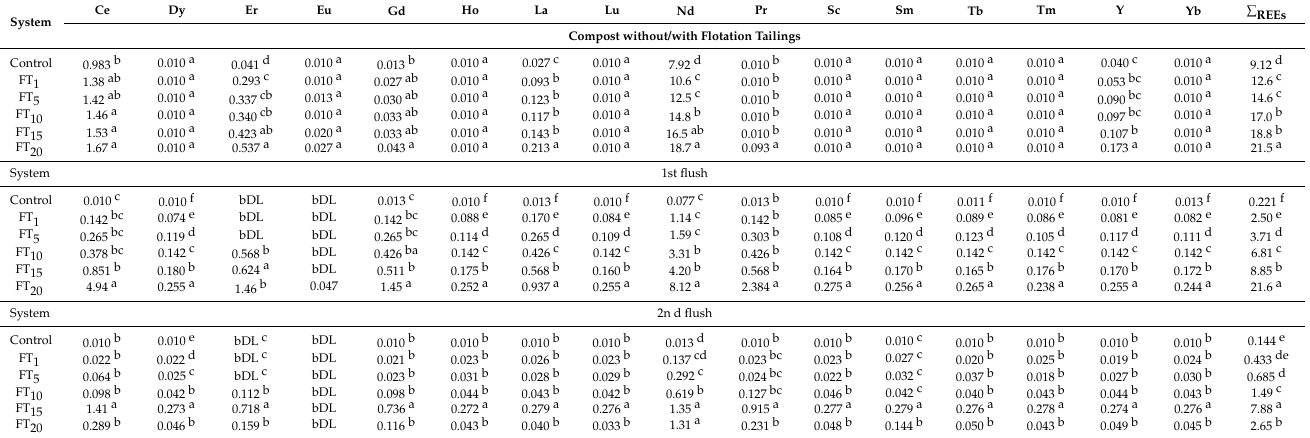
Table 5. Content of rare earth elements [mg kg − 1 dry weight] in compost with flotation tailings before the experiment and fruit bodies from particular flushes.